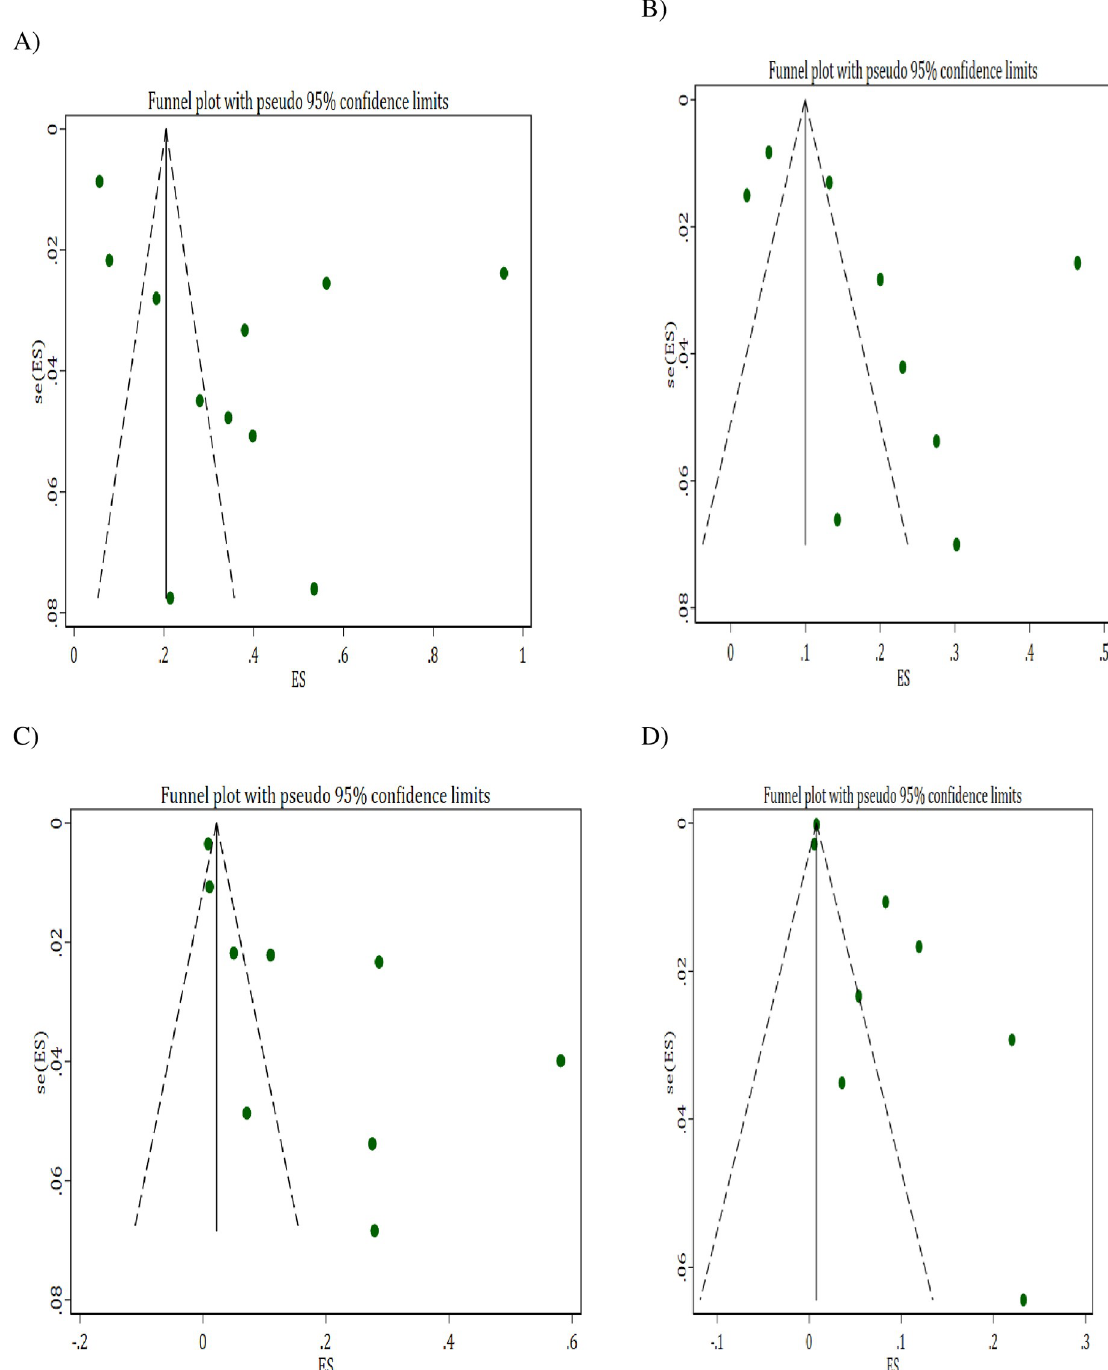
Fig 7. Funnel plot depicting publication bias (A) Overall EPSEs (B) Parkinsonism (C) Akathisia and (D) Tardive Dyskinesia.